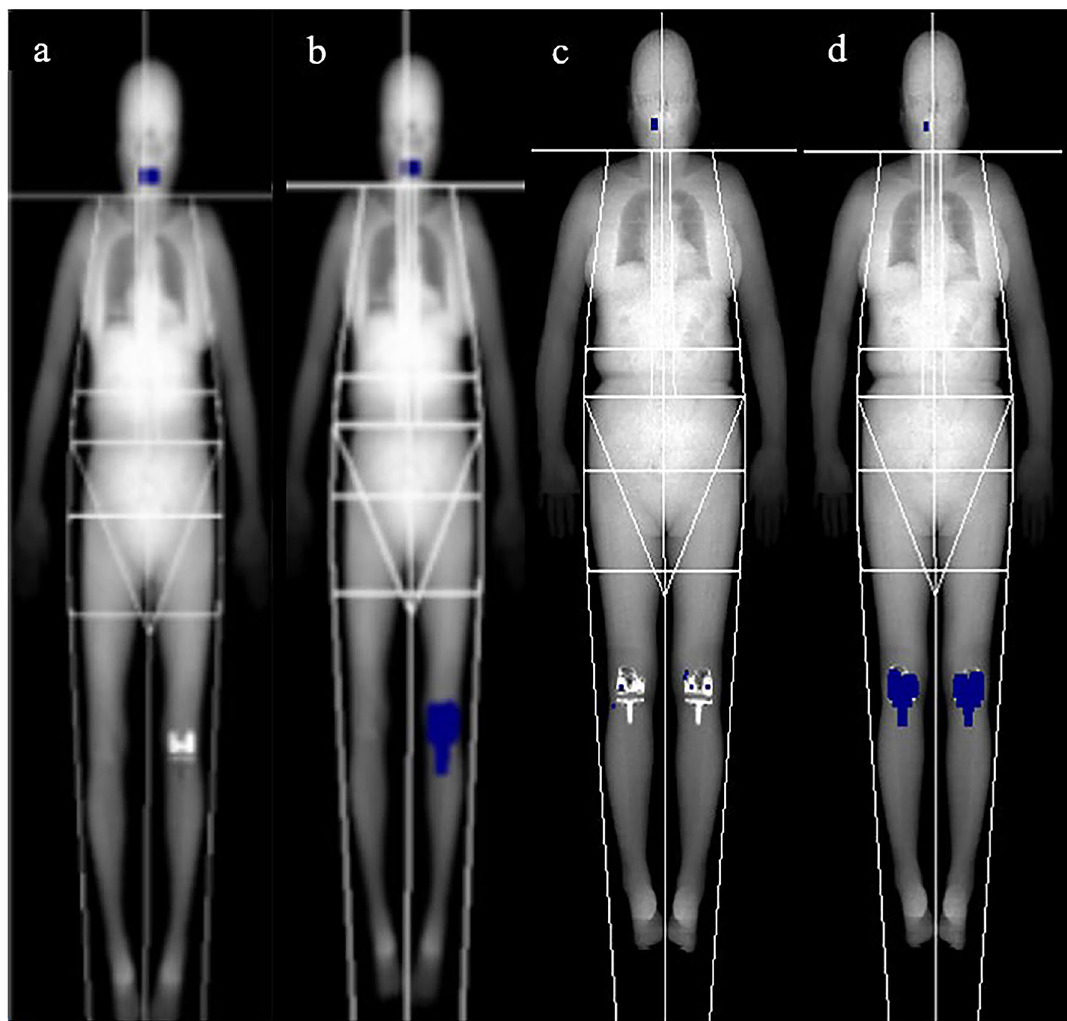
Figure 1. Dual X-ray absorptiometry images with and without automatic metal detection (AMD). ( a ) Left knee arthroplasty without AMD processing. ( b ) Left knee arthroplasty with AMD processing. ( c ) Bilateral knee arthroplasty without AMD processing. ( d ) Bilateral knee arthroplasty with AMD processing. *Images obtained from the Korean Frailty and Aging Cohort